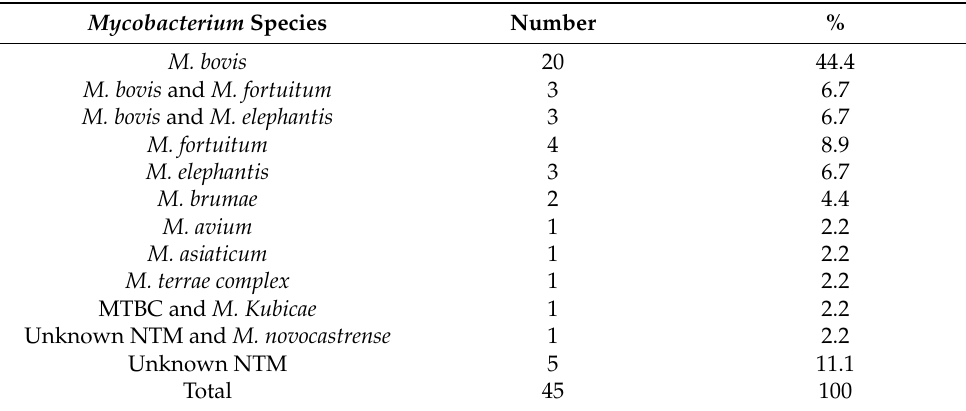
Table 3. Frequency of detected Mycobacterium